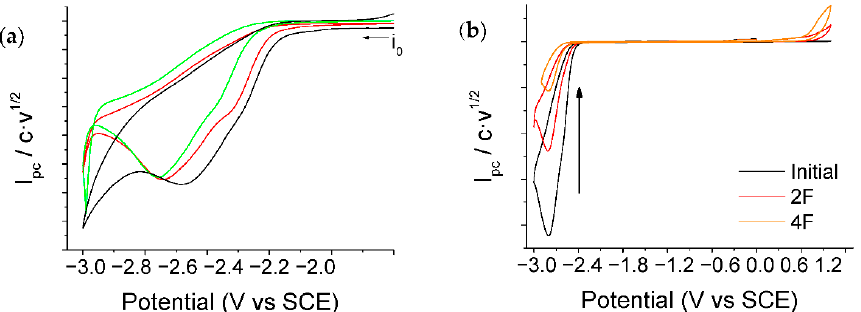
Figure 2. Cyclic voltammetry (CV) of a 5–25 mM solution of 1 in DMF/0.1M TBA PF 6 . Scan rate: 0.3 V · s − 1 . Pt: counter electrode (CE), saturated calomel electrode (SCE): reference electrode (RE). working electrode (WE). ( a ) Glassy carbon (GC, green line), Ag (red line), Cu (black line). ( b ) Electrolysis monitorization through CV using with GC as a WE. Table 1. Electrochemical parameters for a solution of 5.5–15 mM of 1 in DMF/0.1 M TBA PF 6, for WE